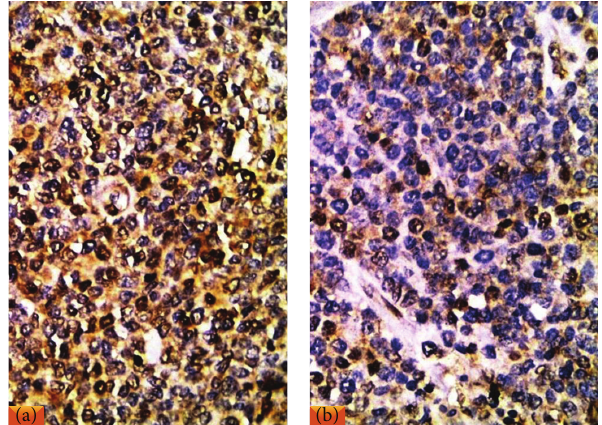
Figure 4: (a) A case of DLBCL showed high nuclear E2F1 expres- sion. (b) A case of DLBCL displayed low nuclear E2F1 expression (IHC × 400 for (a) and